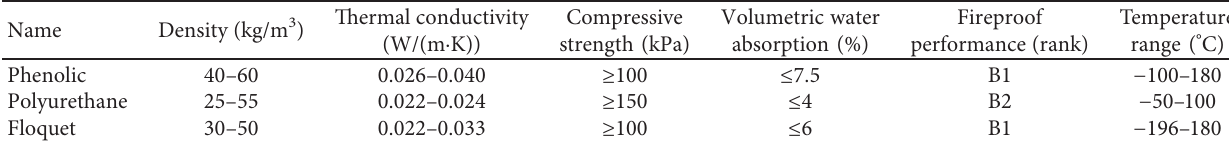
Figure 1: Insulating layer material Table 1: Physical indexes of the thermal insulation layer material.